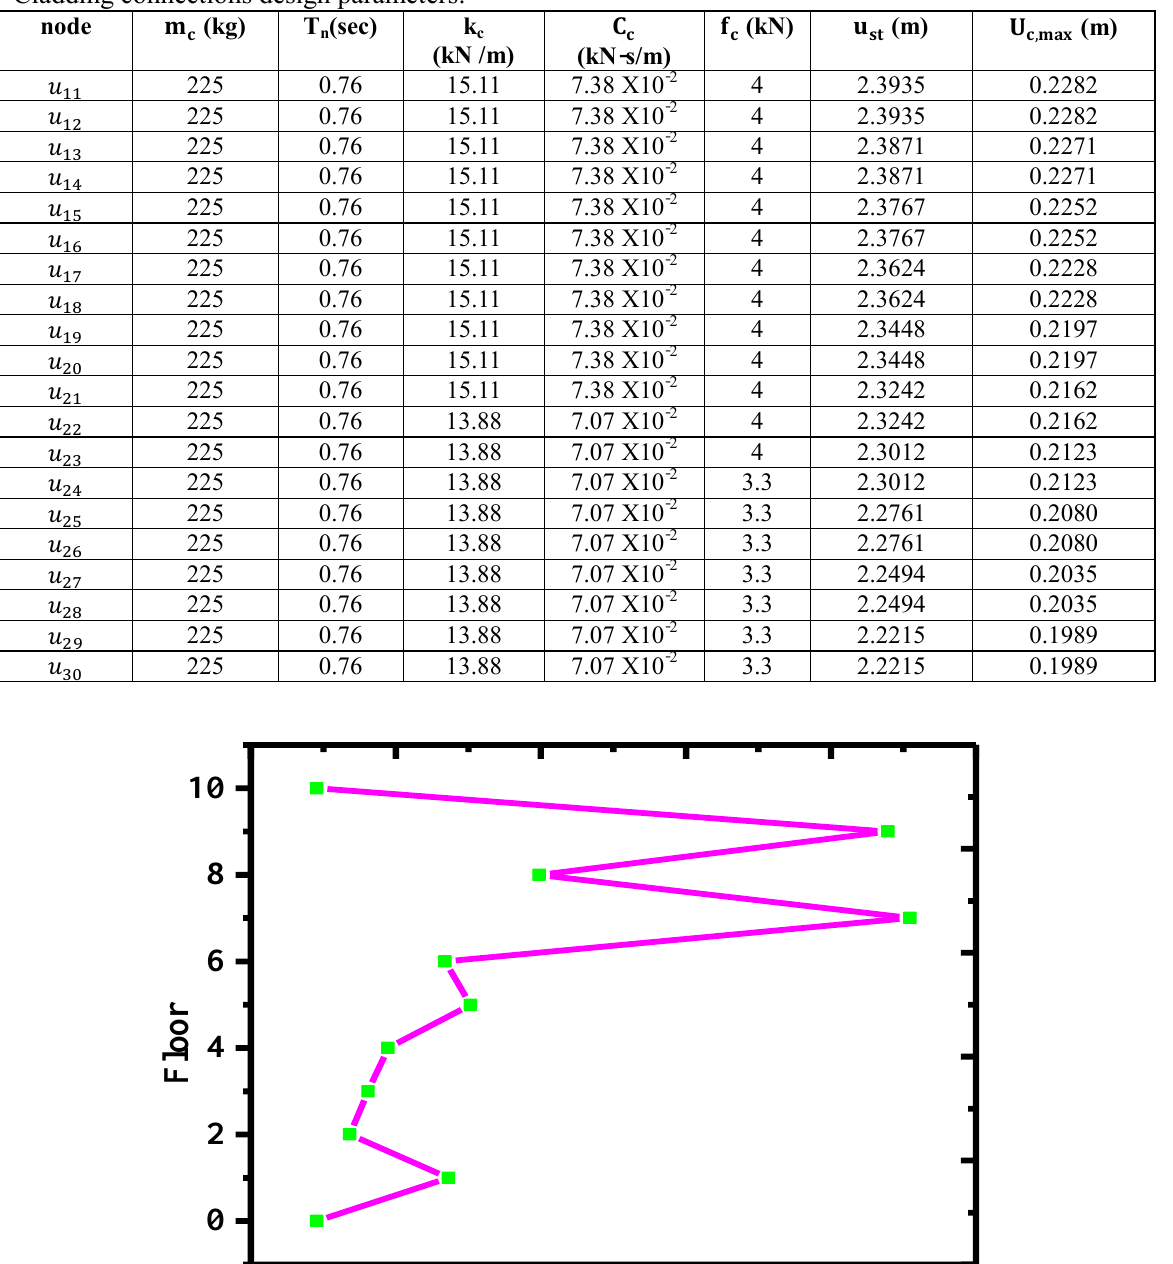
Cladding connections design parameters.